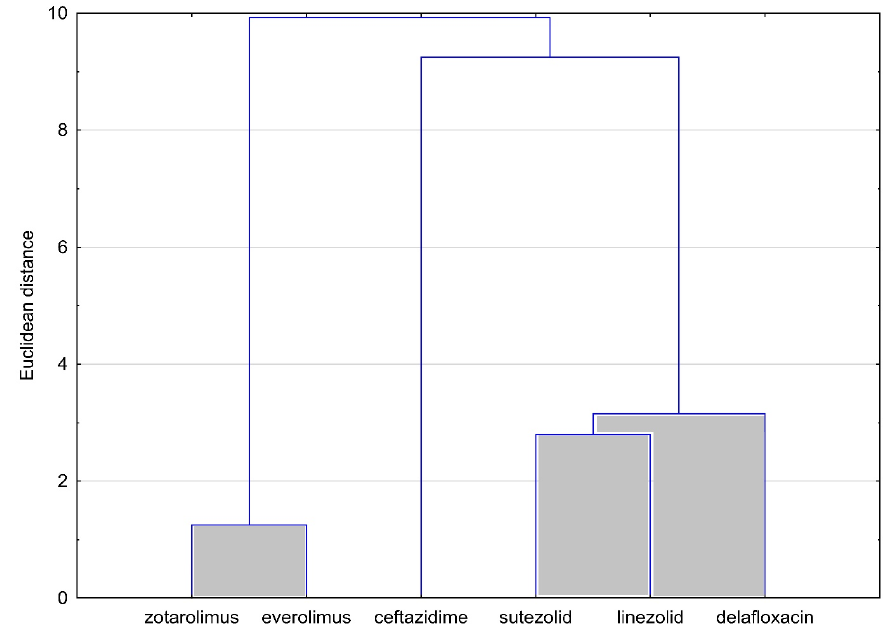
Figure 2. Analysis of the similarities of the tested compounds on the basis of their lipophilicity